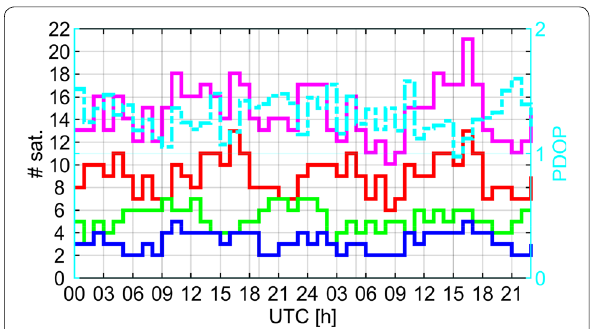
Fig. 6 Number of tracked satellites and corresponding PDOP value during the experiment. Red, green and blue lines correspond to GPS, Galileo and BDS constellation, respectively. Magenta line depicts sum of all system satellites, finally azure line corresponds to multi-constellation